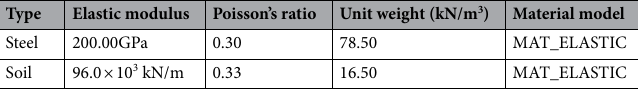
Table 3. Material properties using FE model.